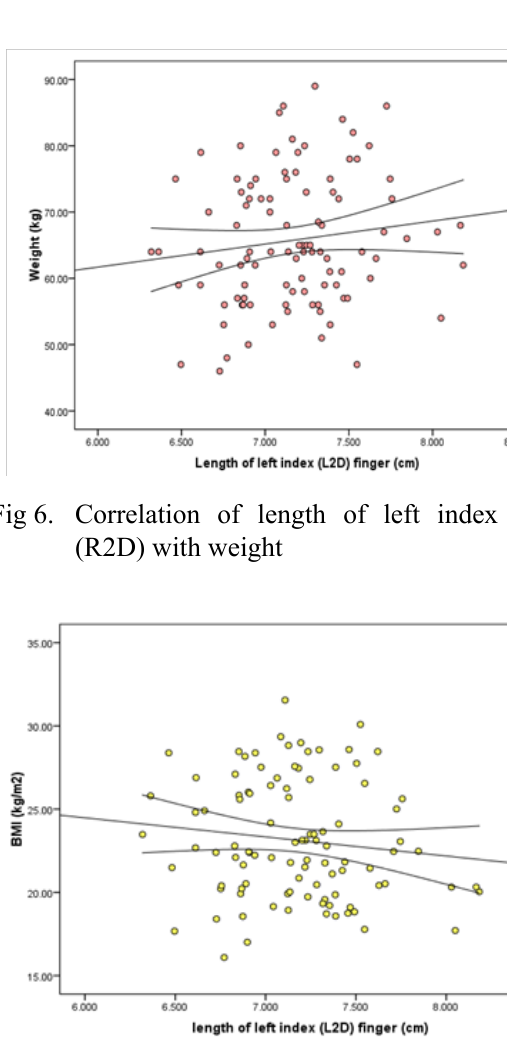
Fig 3. Correlation of length of right index finger (R2D) with height